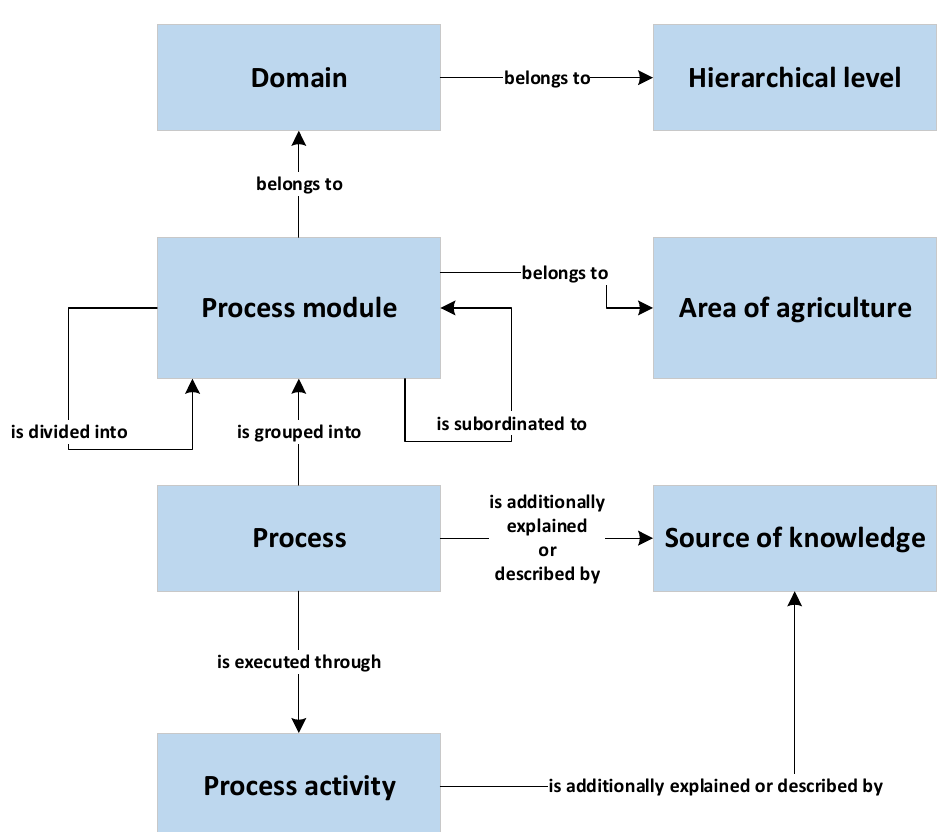
Figure 1. Process description conceptual sub-model.